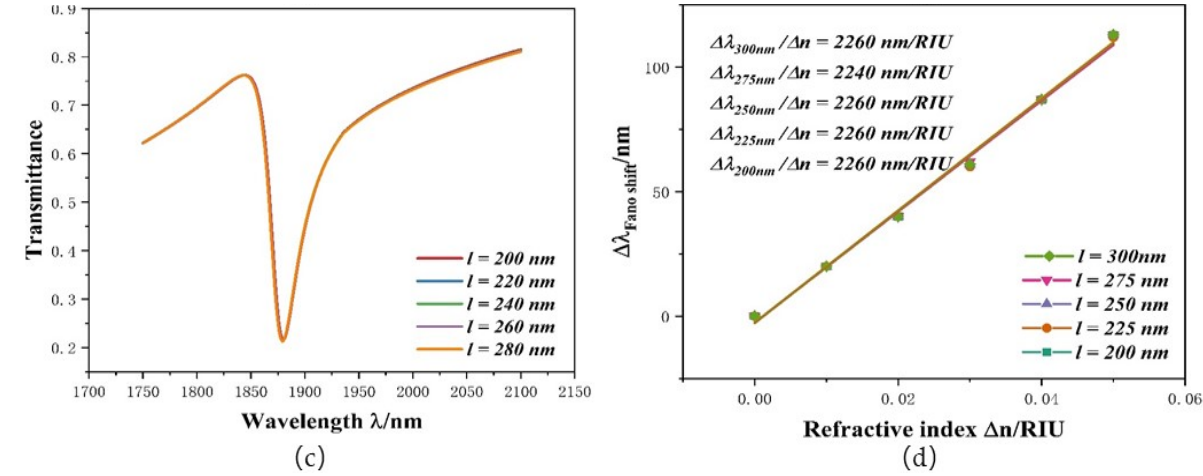
Figure 4. ( a ) Transmission spectra at disparate d values; ( b ) S changes under diverse d values; ( c ) Transmission spectra at disparate l values; ( d ) S changes under diverse l values.